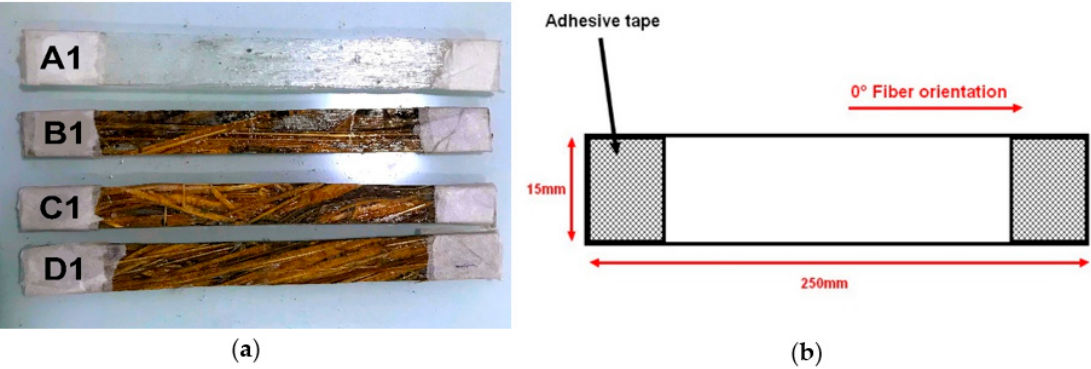
Figure 3. Specimen for tensile test of caranan fiber epoxy composites ( a ) 0% specimens, A1; 10%, B1; 20%, C1 and 30%, D1 ( b ) dimensions according to the standard (ASTM D3039) [39].